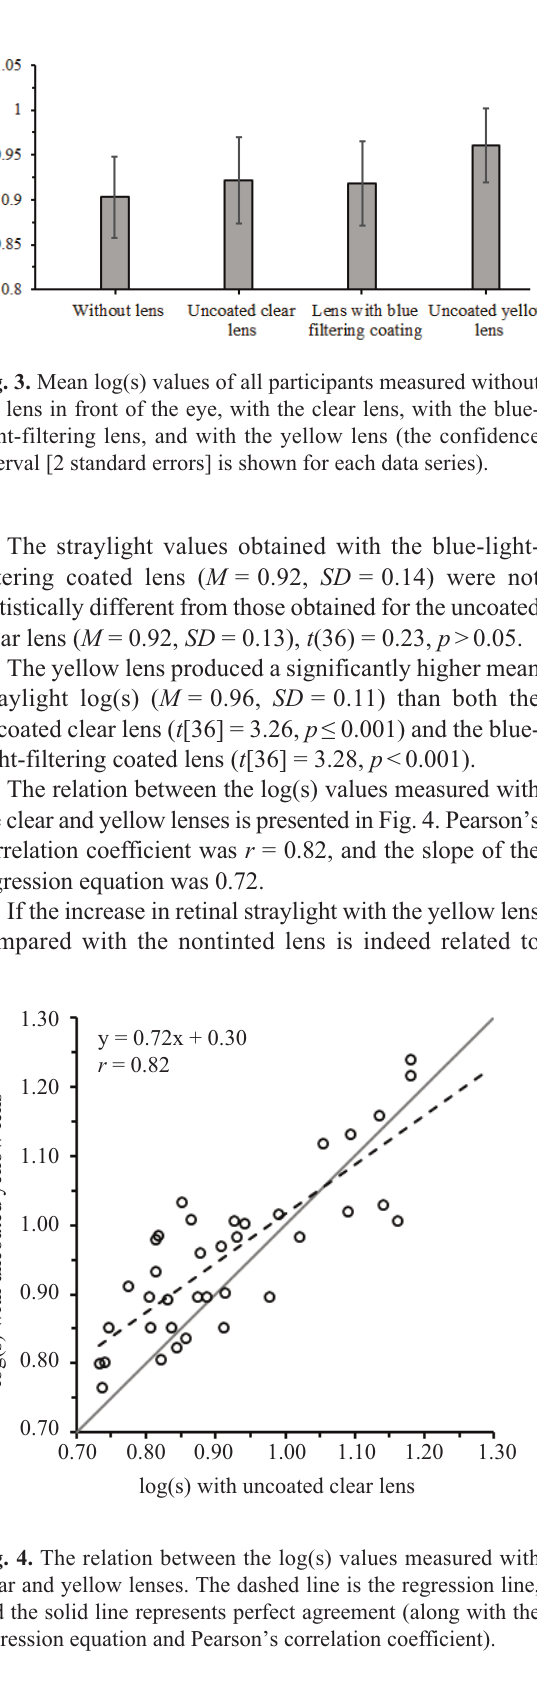
Fig. 4. The relation between the log(s) values measured with clear and yellow lenses. The dashed line is the regression line, and the solid line represents perfect agreement (along with the regression equation and Pearsonʼs correlation coefficient).